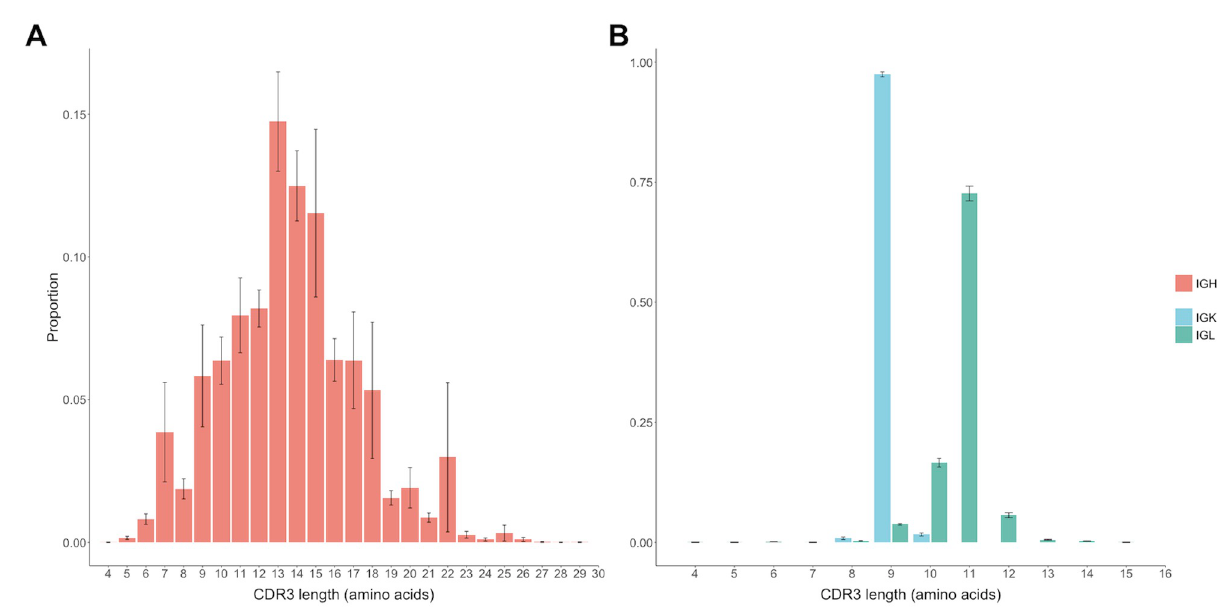
Fig 9. CDR3 lengths for the heavy (A) and light chains (B) of the controls. Distribution of functional clone size was calculated as the average proportion of functional clones for each observed CDR3 length. CDR3 length is defined from position 105 to 117 without the conserved cysteine of FR3 nor the first tryptophan/phenylalanine of